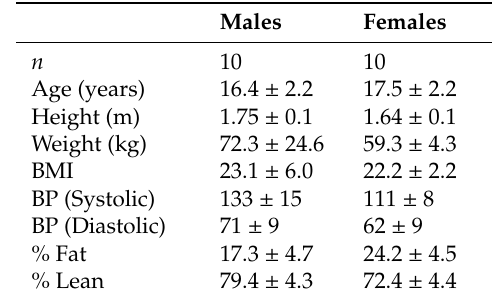
Table 2. Participant